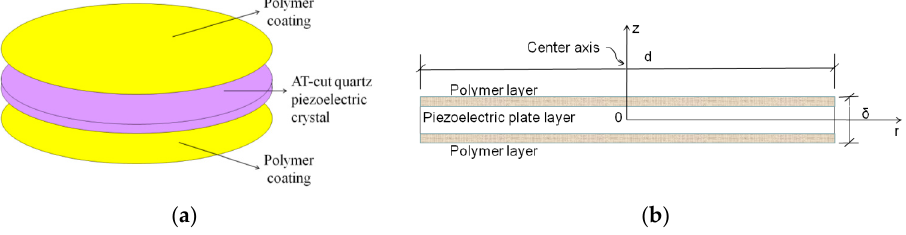
Figure 4. Photo of the sensor.